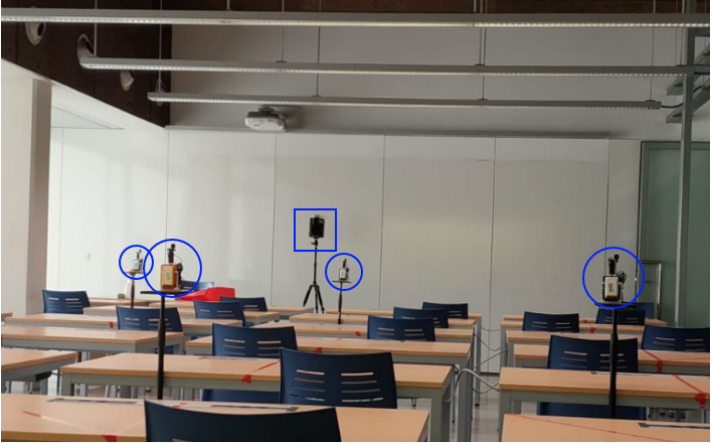
Figure 3. Measurement of parameters in the classroom using the designed system. Detail of sound source location (square mark) and receiver nodes (circular